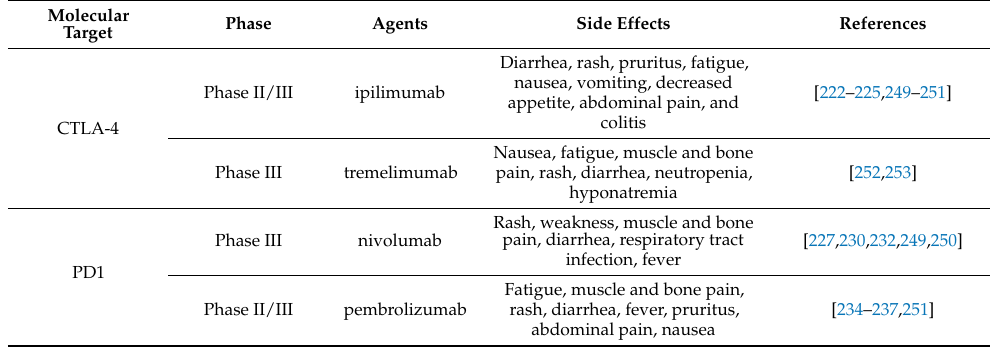
Table 2. Currently approved immune checkpoint inhibitors and related side